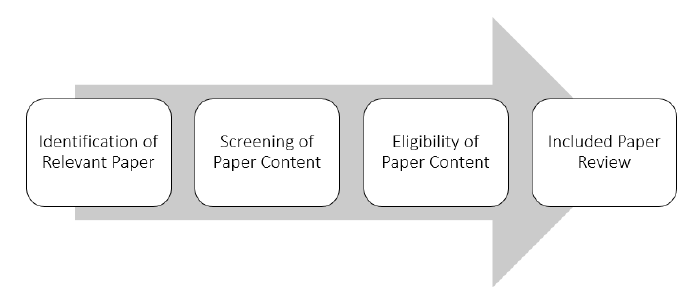
Fig. 1. Research phase adapted from PRISMA method [13]